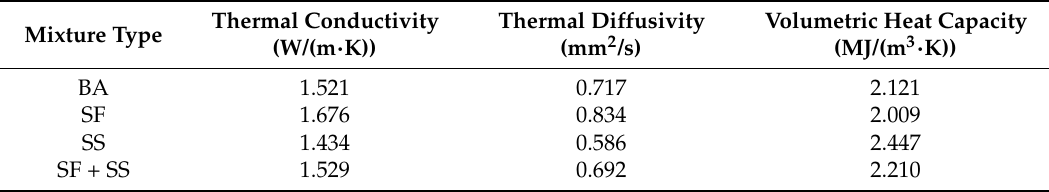
Table 3. Thermal parameters of four kinds of asphalt